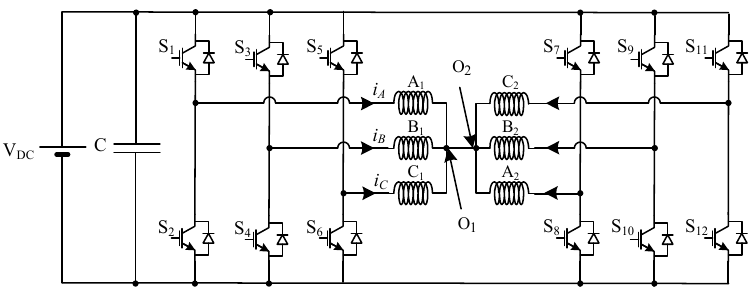
Figure 33. Fault-tolerant topology proposed by [99], on a specific design of a DCSRM (dual-channel SRM) driven by two three-phase standard inverters.